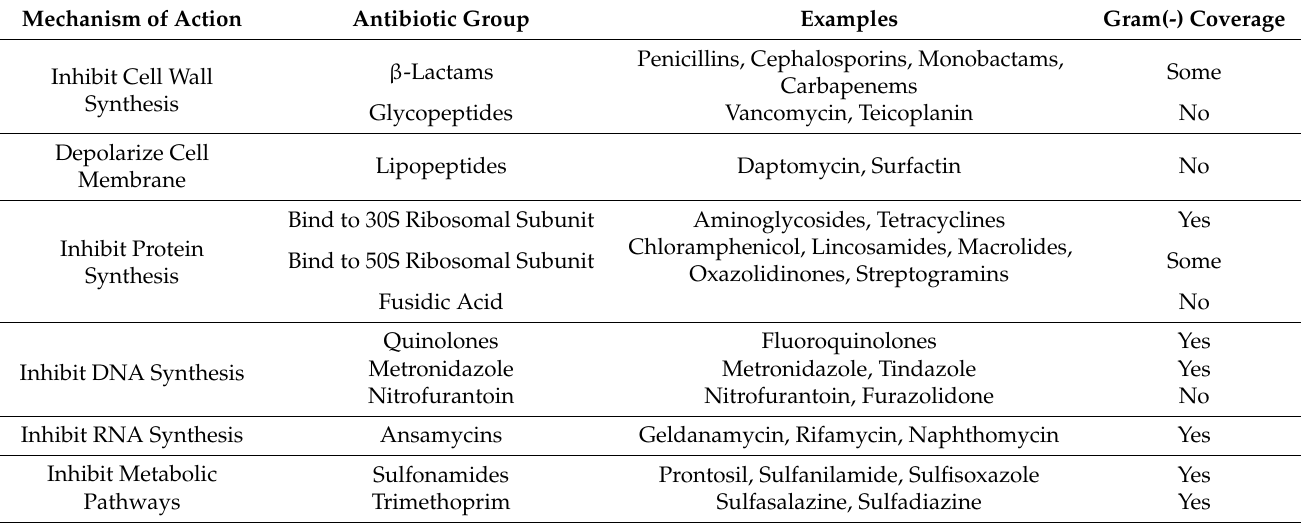
Table 3. Mechanism of action and sensitivity against Gram-negative bacteria of each antibiotic